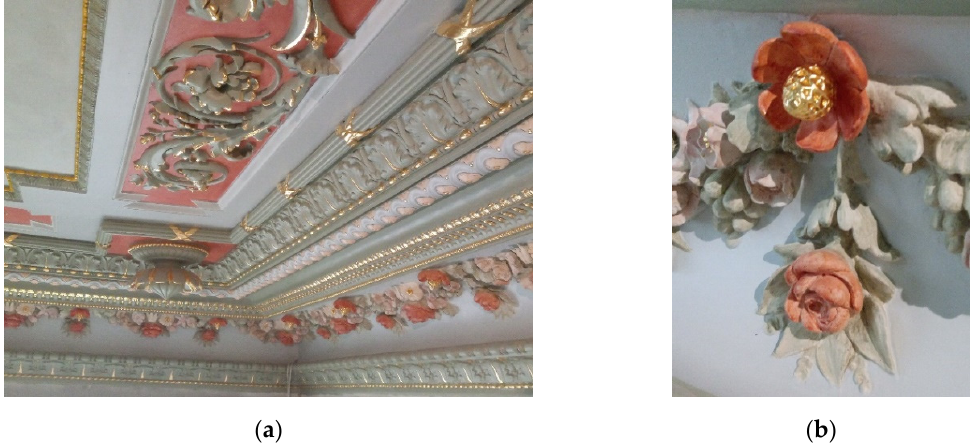
Figure 2. Stucco renovation on the ceiling: ( a ) partial view on the ceiling; ( b ) view of the gilded floral detail.